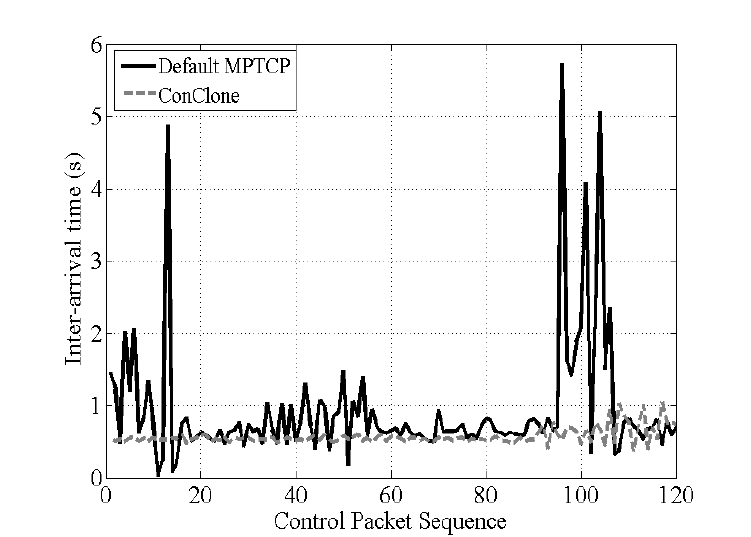
Figure 10. Inter-packet times of control